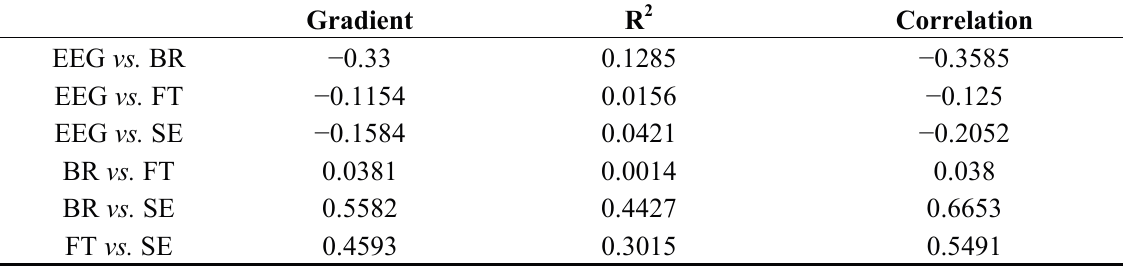
Table 8. The results of gradient, R 2 , and correlation between each set of acquired